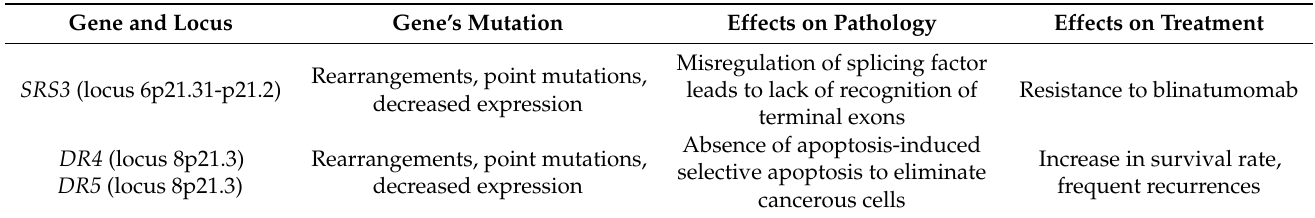
Table 9. Characteristics of genes and their mutations responsible for resistance to new targeted therapies. Gene and Locus Gene’s Mutation Effects on Pathology Effects on Treatment Misregulation of splicing factor Rearrangements, point mutations, SRS3 (locus 6p21.31-p21.2) Resistance to blinatumomab leads to lack of recognition of decreased expression terminal exons Absence of apoptosis-induced DR4 (locus 8p21.3) Rearrangements, point mutations, Increase in survival rate, selective apoptosis to eliminate DR5 (locus 8p21.3) decreased expression frequent cancerous cells